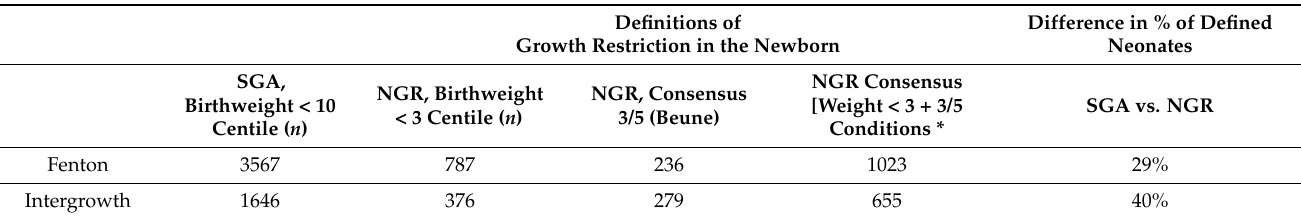
Table 3. Percentage of SGA defined as NGR by consensus definition [5] depending on the chart used (Fenton vs. Intergrowth).